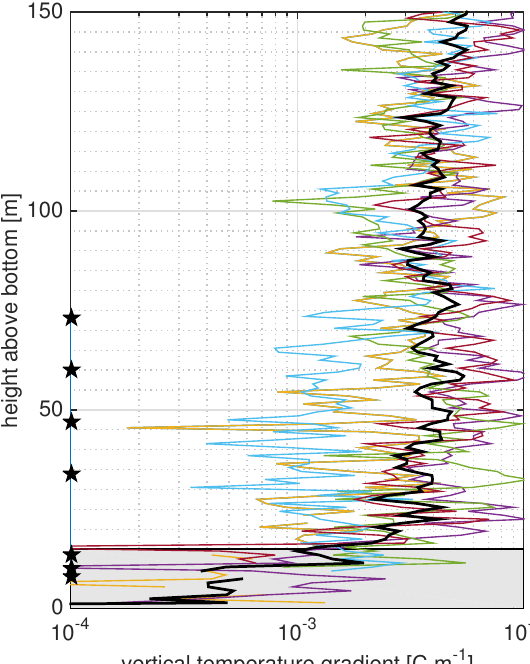
Figure 8. Vertical profiles of potential temperature gradient estimated from CTD tow-yos about the deep mooring, Figure 2. Colored traces represent the mean temperature gradients for 5 tow-yos, the thick black trace represents the mean of those five. The grey shaded region represents the reduced stratification in the bottommost 15 m, smaller than the nominal height scale of the stratified Ekman layer and slightly larger than that documented in the moored sensors. Pentagrams on the left indicate the vertical disposition of the moored instrumentation. Tow-yo sampling extends to 10–15 m H ab , with 35% of the casts to within 5 m of the